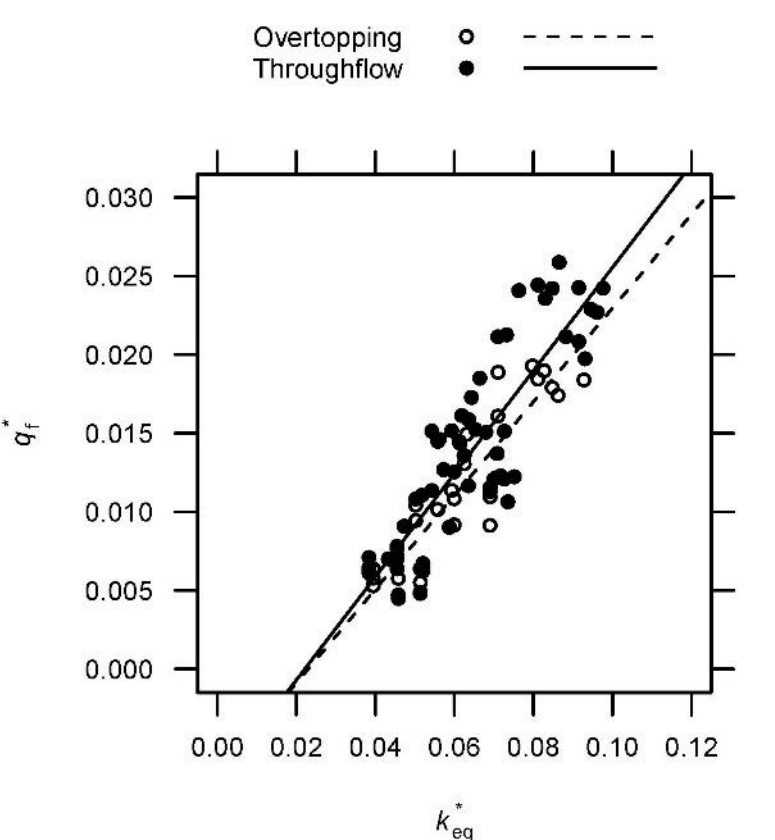
Figure 15. Variation of 𝑞 f∗ with 𝑘 eq∗ differentiating by the type of flow. Those physical models where the differentiating variable was the type of impervious element (central core or upstream face) were also compared. In this case, we could somehow expect to observe some differences in the value of q f . The process through which water infiltrates was the same, overtopping, but the flow paths inside the body of the dam were longer for dams with an upstream face, which did not necessarily imply a difference in the position of the first emergence point. Results from the statistical analysis performed on tests n o 22 and 123 (PPM/CC) and n o 124 and 128 (CPM/UF) indicate that the type of impervious element does not have a significant impact on the value of q f . The p -value = 0.124 allows us to reject the alternative hypothesis for an α = 0.05. The statistical power is about 73%, so here we have a 27% chance of rejecting the alternative hypothesis when it should be accepted. Crossing these results with Figure 16 makes us confident to state, for now, that the type of impervious element does not affect q f . Figure 17 presents the images of both tests and discharge steps used in the construction of the Figure 16 plot. Besides this comparison, Figure 18 shows the relation between k ∗ and q ∗ differentiating between tests eq f performed with upstream face (UF) and central core (CC). Here, we also cannot see any clear separation between both scatter